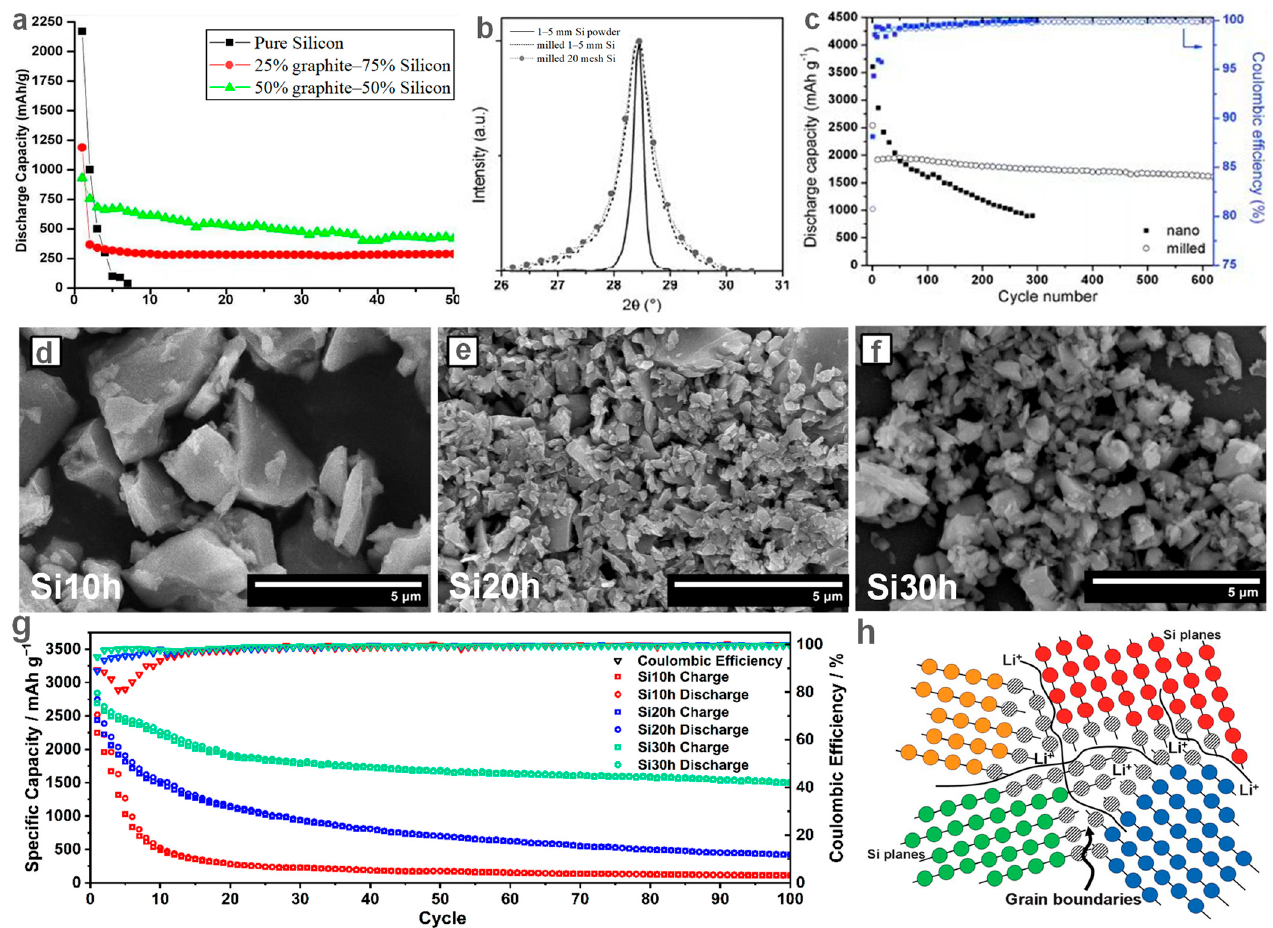
Figure 1. ( a ) Cyclability of 50% graphite–50% silicon [50]. ( b ) XRD patterns of the as-received 1–5 mm Si powder (black line), milled 1–5 mm Si powder (dotted black line), and milled 20 mesh Si powder (dashed gray line with filled circles). ( c ) Discharge capacities and coulombic efficiencies with cycling of milled millimetric Si (O) or nanosized Si-based electrodes for full discharges. Reproduced with permission [51]. Copyright 2013, The Royal Society of Chemistry. ( d – f ) SEM images of silicon particles resulting from the ball-milling process for 10 h (Si10h), 20 h (Si20h), and 30 h (Si30h). ( g ) Cycling stability curves of the cells with Si 10h, Si 20h, and Si 30h electrodes at 400 mA g − 1 . Reproduced with permission [54]. Copyright 2022, MDPI. ( h ) Scheme of the nanocrystalline structure of the milled Si powder showing grain boundaries (hatching) where faster Li diffusion is supposed to occur. Reproduced with permission [51]. Copyright 2013, The Royal Society of Chemistry.